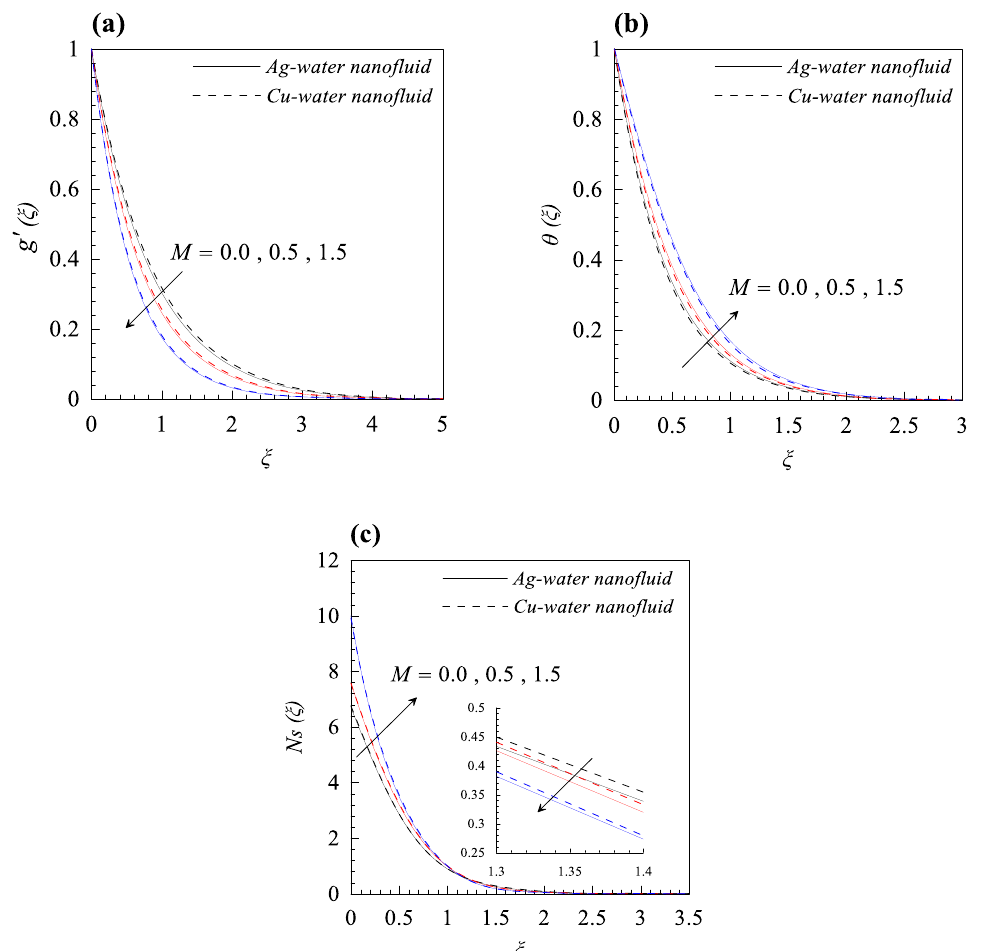
( ) g  , ( b ) temperature